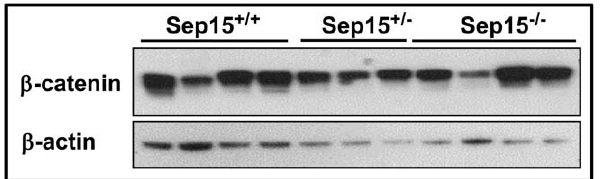
Table S2 List of statistically significantly greater than